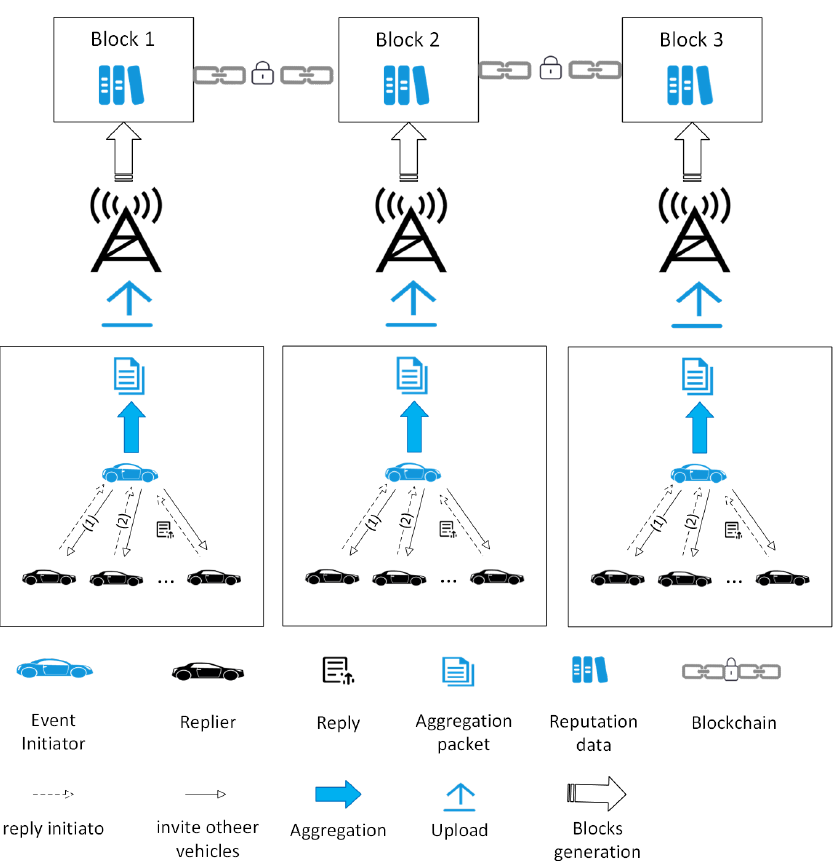
Figure 9. Structure of Privacy-Preserving Announcement Protocol With Blockchain-Based Trust Management proposed in